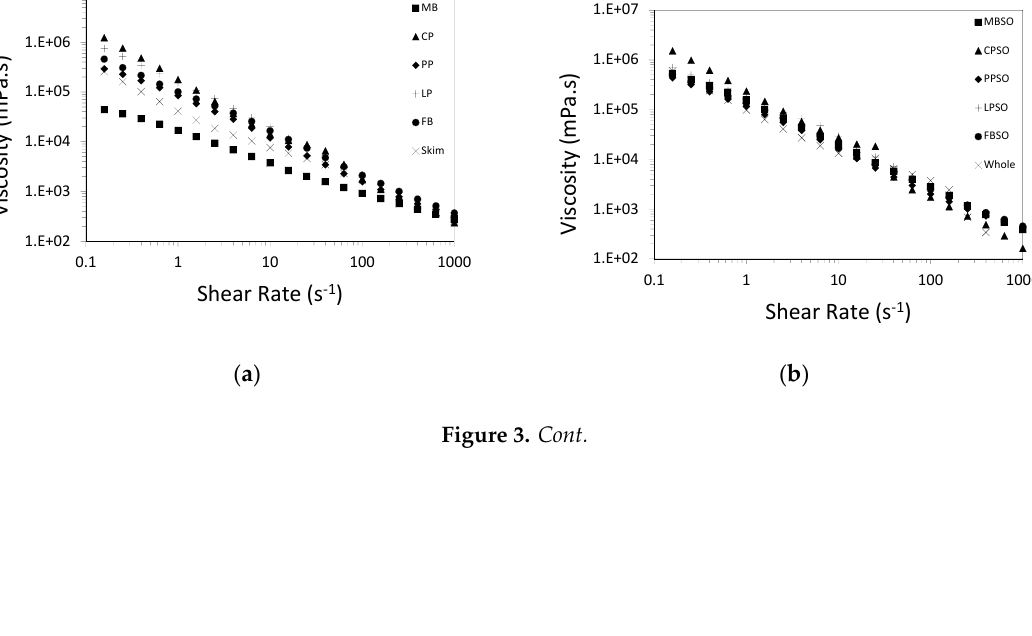
Figure 3. Flow curves ( a , b ) and viscosity at 1 s − 1 ( c , d ) of high pressure-treated 12% ( w / w ) mung bean (MB), chickpea (CP), pea (PP), lentil (LP), and faba bean (FB) protein samples without and with 5% ( w / w ) sunflower oil (SO) as compared to commercial plain skim and whole milk Greek yogurt. Each curve is the average of two treatments. The average of two treatments is presented with the error bar extremes showing the data for each treatment. 3.3. Feasibility of Using HPP to Develop Plant-Based Yogurts In this proof-of-concept study, the viscosity and viscoelastic properties of high pressure- structured plant protein gels have been shown to be comparable in behavior to commercial dairy yogurts, though further optimization and sensory evaluation is required. As different plant proteins exhibit variation in behavior, the gel properties could be simply tailored by blending different plant protein ingredients or by controlling pressure level [8]. Besides having customizable texture using minimal ingredients, the higher protein content and short processing time makes HPP an advantageous structuring method for plant-based yogurts. The fermentation of plant-based substrates may still be needed for flavor production. Apart from having textural challenges in current plant-based yogurt-making, plant-based milks contain low